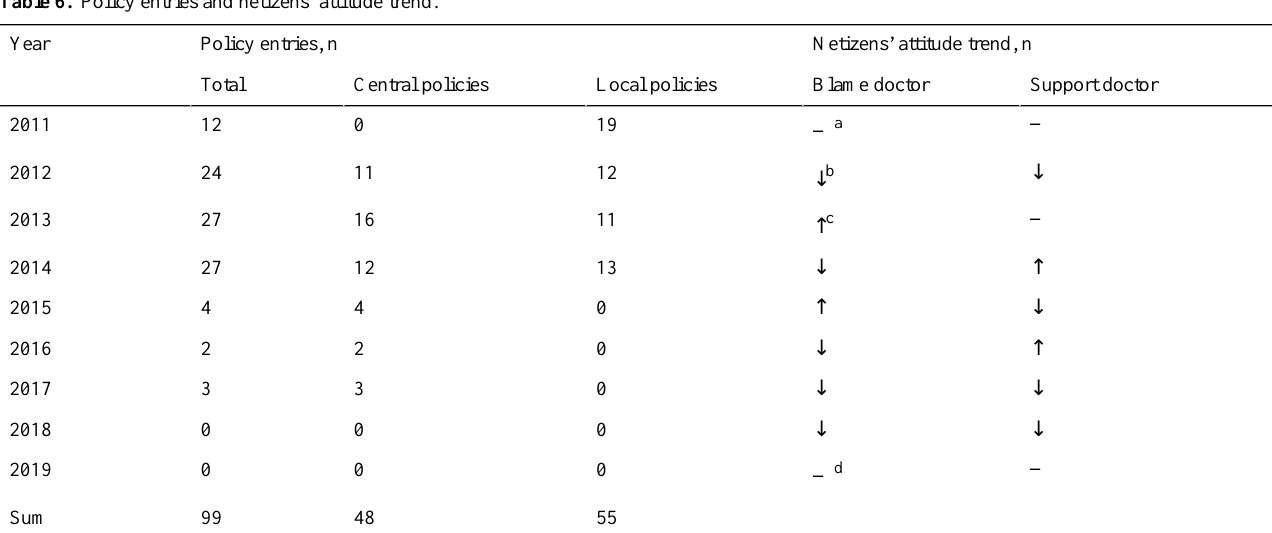
Table 6. Policy entries and netizens’attitude